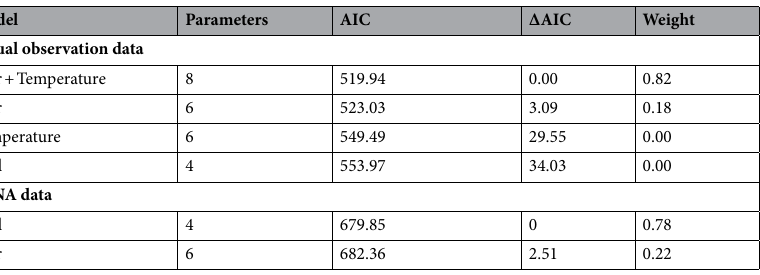
Table 2. Comparison of candidate models for the detection component of a multispecies occupancy model for the Hazara Torrent Frog ( Allopaa hazarensis ) and Murree Hills Frog ( Nanorana vicina ). AIC = Akaike Information Criterion, ΔAIC = the difference in AICc values between the given model and the model that is most likely to have generated the data (i.e., the one with the lowest AICc), and is a relative measure conditional on the candidate set of models.